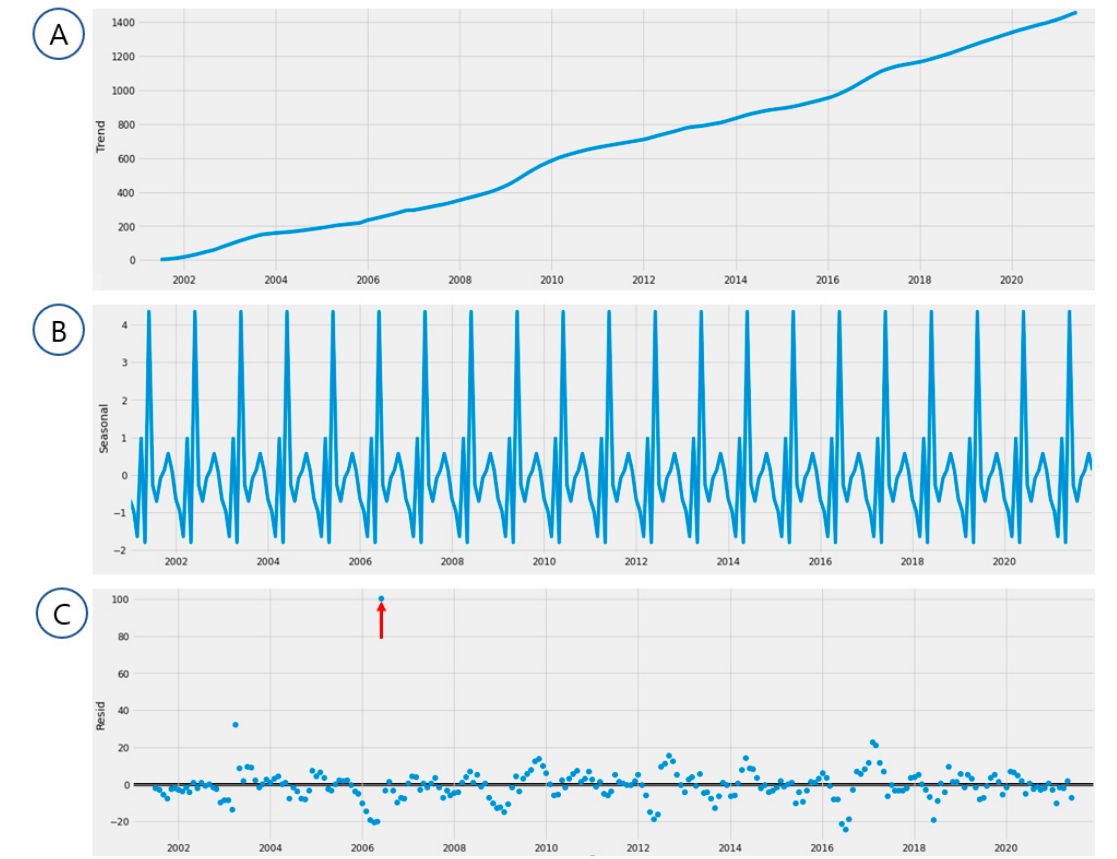
Figure 4. Time series decomposition for the LINAC downtime dataset. ( A ) The downtime increased over the years. ( B ) The time series has seasons uninfluenced by the specific seasonal factor. ( C ) The downtime surge occurred due to major LINAC part replacement from 2006 to 2007.